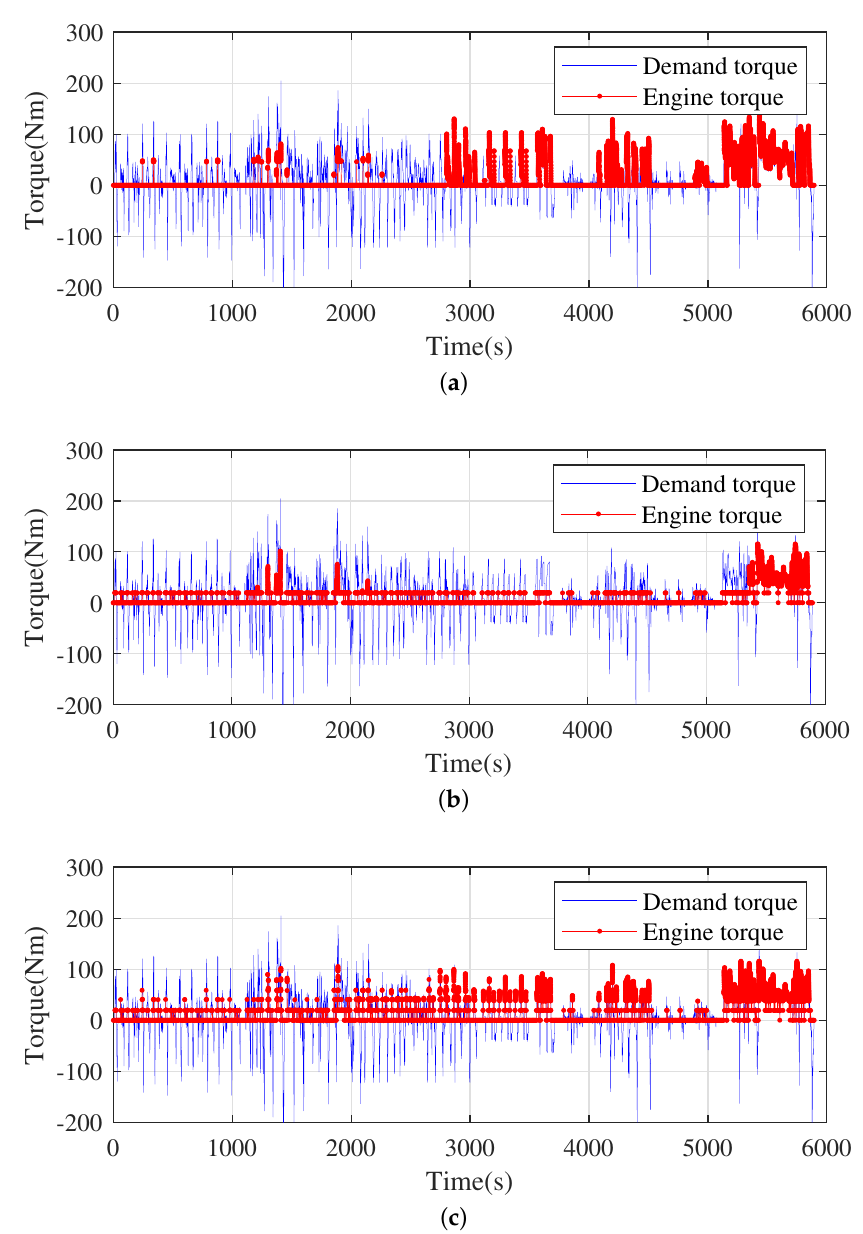
Figure 16. The results of different strategies. ( a ) The engine torque of CD-CS; ( b ) the engine torque of ECMS; ( c ) the engine torque of the proposed